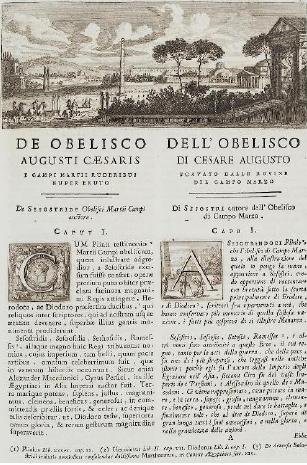
Figure 6: p1, Angelo Maria Bandini, Dell'obelisco di Cesare Augusto scavato dalle rovine del Campo Marzo, Roma 1750